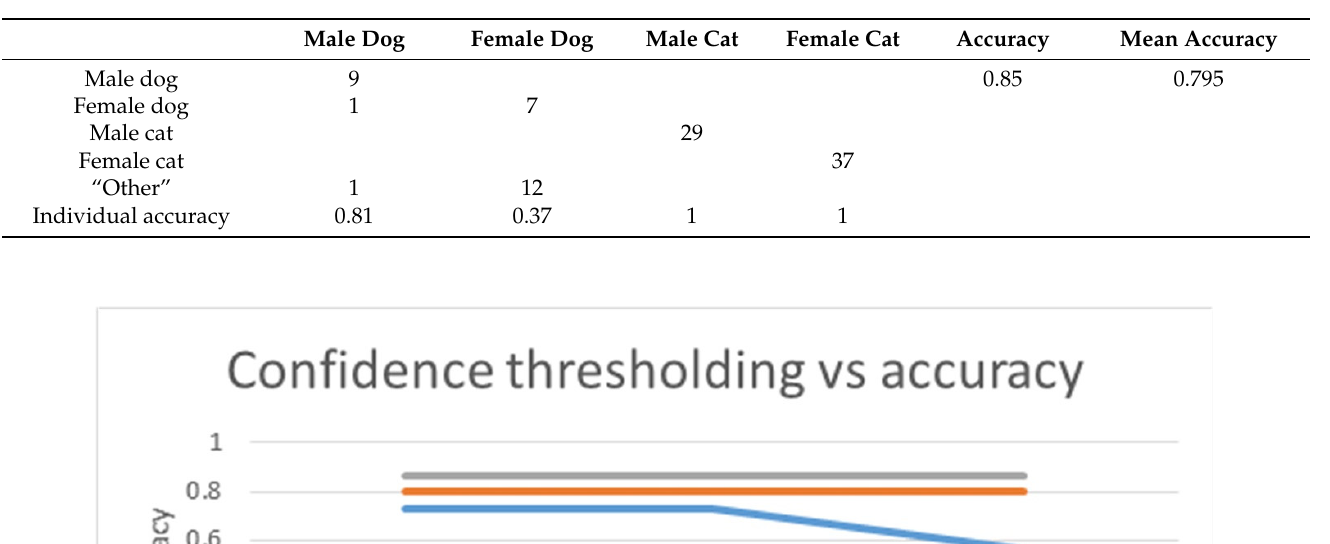
Table 15. The performance of Yolov4 majority voting for multi-classification.